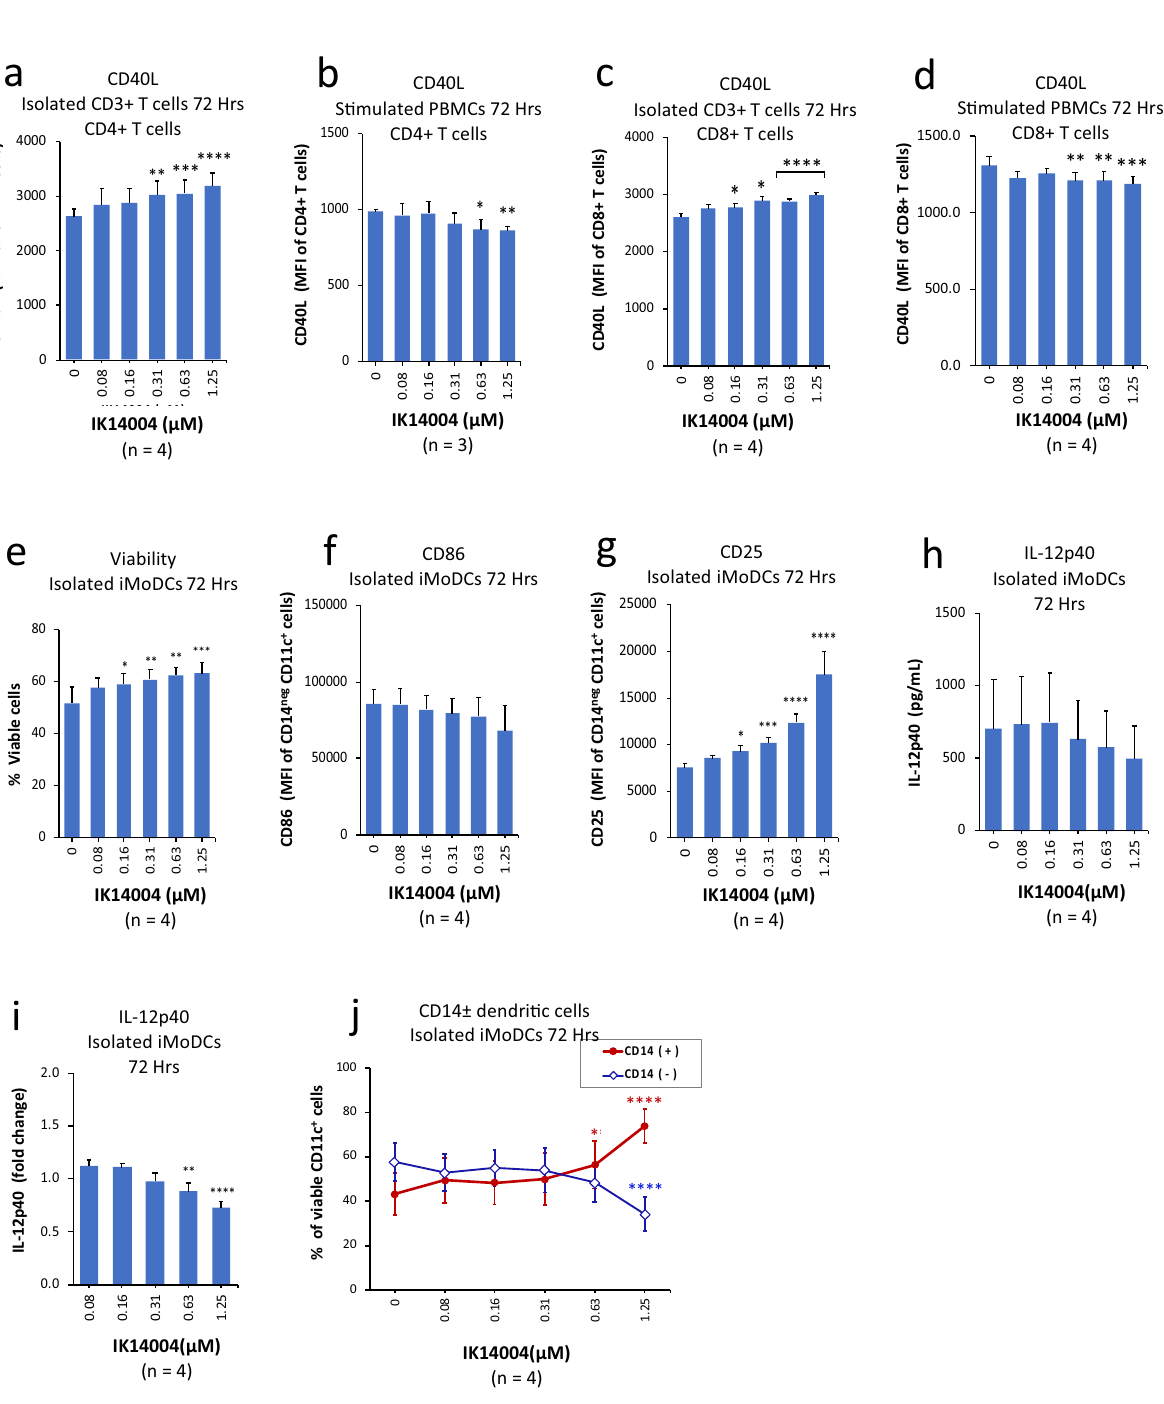
Figure 2. IK14004 suppresses DC licensing and maturation. Immature monocyte-derived dendritic cells (iMoDCs) were prepared as described in the “Methods”. Each tissue culture experiment involving use of either monocytes, PBMCs or isolated CD3+ T cells was performed using triplicate wells (technical replicates) and flow cytometry/ELISA experiments were repeated at least three times (n = experimental replicates) as indicated below each panel. All error bars represent standard error of the mean (SEM). In all experiments the culture duration was 72 h. The compound shown is IK14004 as indicated under each panel. Flow cytometry data are shown as mean fluorescence intensity (MFI). Dot plots and gating strategies are shown in Supplementary Figs. S10 to S17. ( a ) Expression of CD40L in CD4+ T cells within T cell cultures. ( b ) Expression of CD40L in CD4+ T cells within PBMC cultures. ( c ) Expression of CD40L in CD8+ T cells within T cell cultures. ( d ) Expression of CD40L in CD8+ T cells within PBMC cultures. ( e ) Viability of immature monocyte-derived dendritic cell (iMoDC) cultures. ( f ) Expression of CD86 in iMoDC cultures. ( g ) Expression of CD25 in iMoDC cultures. ( h ) IL-12p40 levels in supernatant from iMoDC cultures. ( i ) IL-12p40 production by iMoDCs expressed as fold-change between the highest and lowest IK14004 concentration, respectively, with vehicle-treated cells normalised to 1. ( j ) Reversion of CD14 negative iMoDCs to CD14+ monocytes. Data were analysed using repeated measures (RM) two-way ANOVA with Dunnett’s post-test comparing peptide with vehicle control. *P < 0.05, **P < 0.01, ***P < 0.001, ****P <